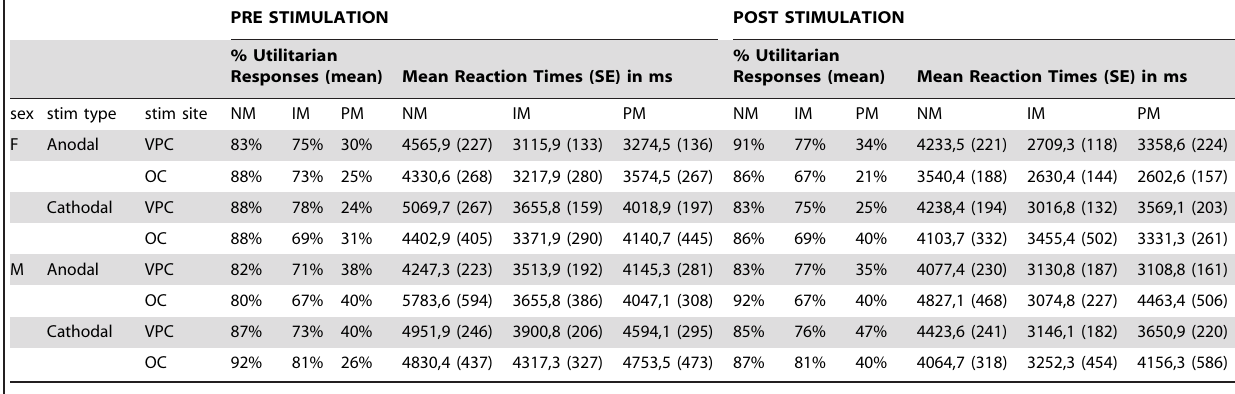
PRE STIMULATION POST STIMULATION